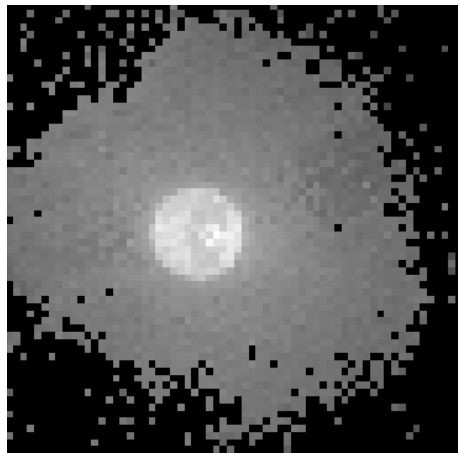
Figure 9. Reconstructed image showing the illumination level obtained with the fast LED switching experiment in Selective Change Driven (SCD) mode.